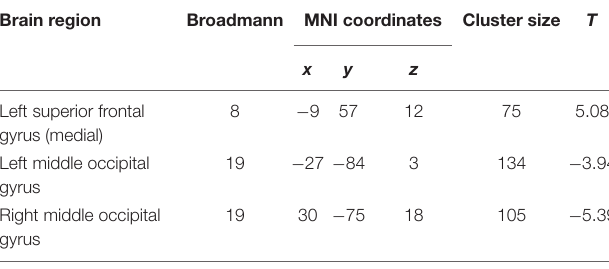
TABLE 4 | Amplitude of low-frequency fluctuation differences between the post treatment and baseline in the patient group. Brain region